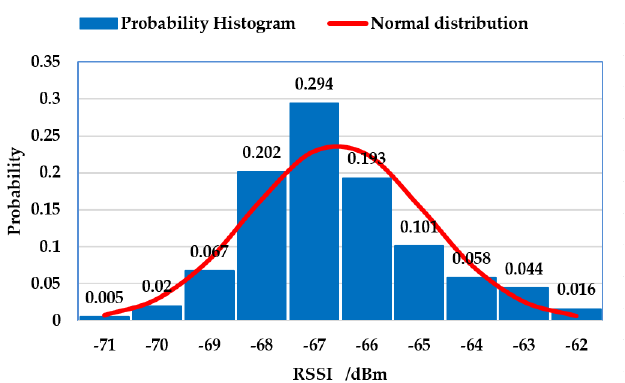
Figure 4. This histogram indicates the RSSI probability distribution of measured values. The x -axis is the intensity value of the received signal, and the y -axis represents the probability of the received signal intensity values in 1000 measurements. The curve is the normal distribution of the measured